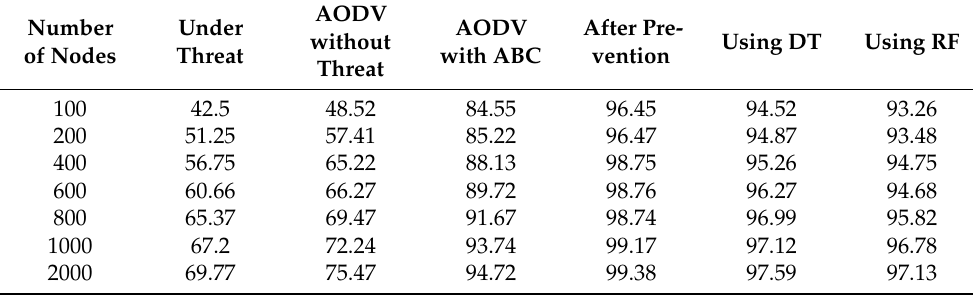
Table 4. Packet delivery